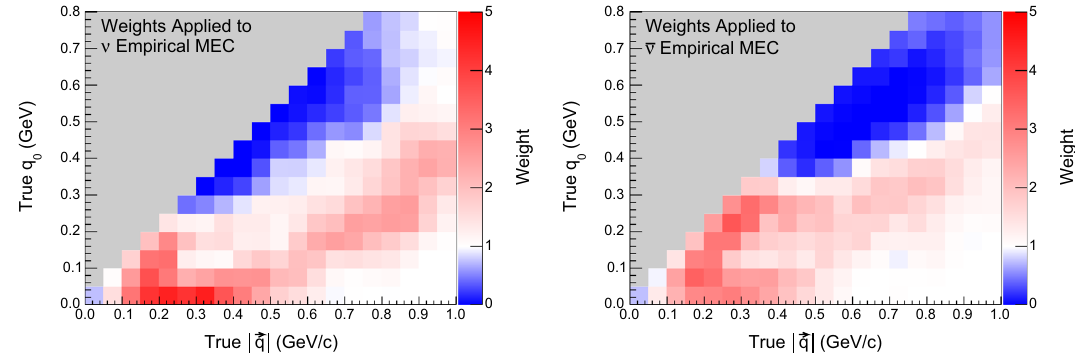
Fig. 4 The weights, in three-momentum and energy transfer, applied to simulated Empirical MEC interactions to produce the fitted NOvA 2p2h predictions described in the text, for neutrinos (left) and antineutrinos (right). Gray indicates kinematically disallowed regions, where no weights are applied